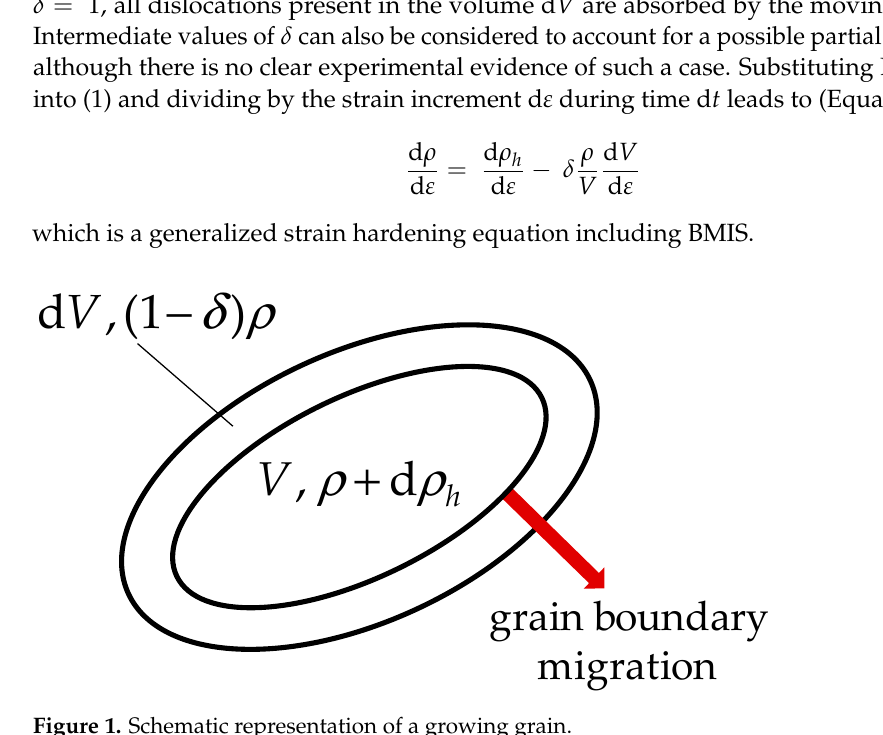
Figure 1. Schematic representation of a growing grain.